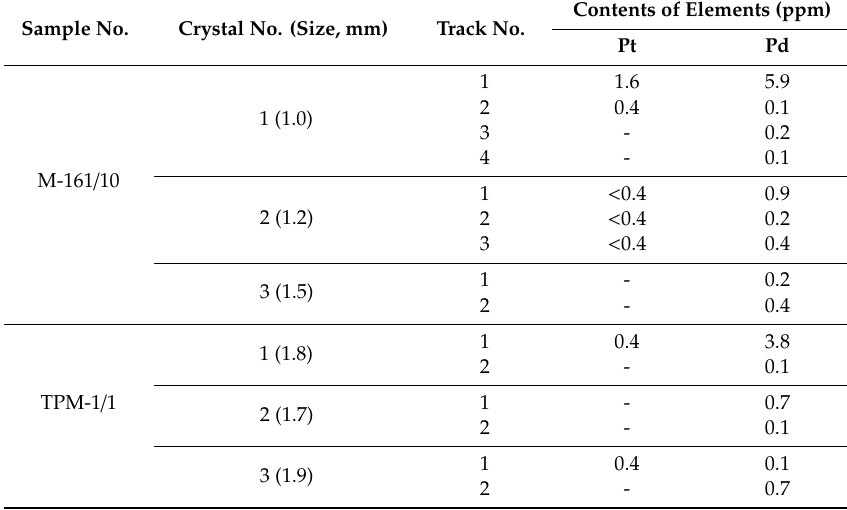
Table 11. Results of LA-ICP-MS analysis of the surface of pyrite crystals for Pt and Pd (the Natalkinskoe deposit). Sample